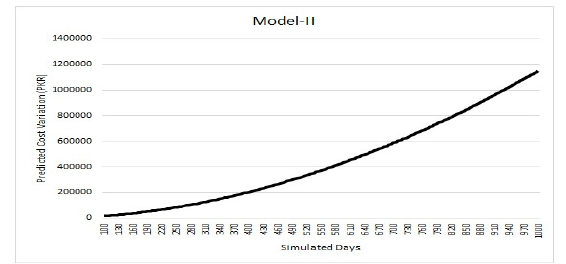
FIG. 3: INTERPRETATION OF MODEL-I REGRESSION